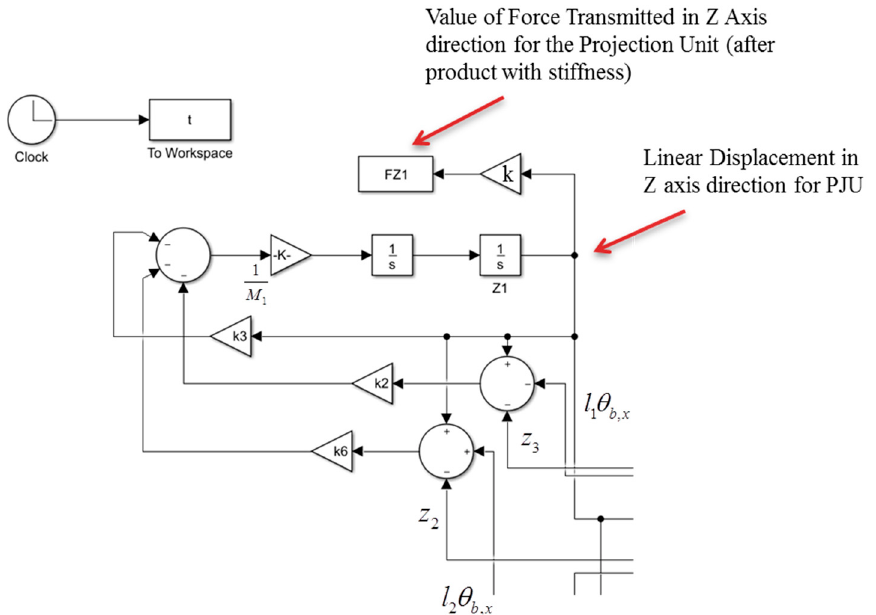
Figure 9. Simulink model for force transmission .